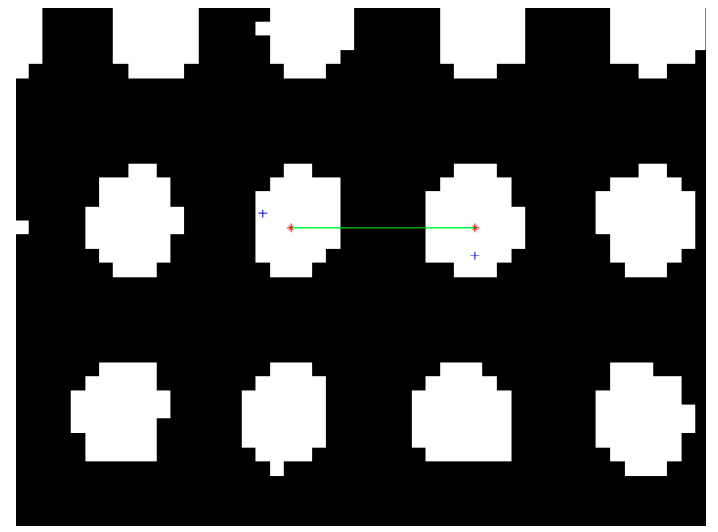
Figure 4. The user with blue (+) and the centroids of each blob in red (*). Figure 5. The user with blue ( + ) and the centroids of each blob in red